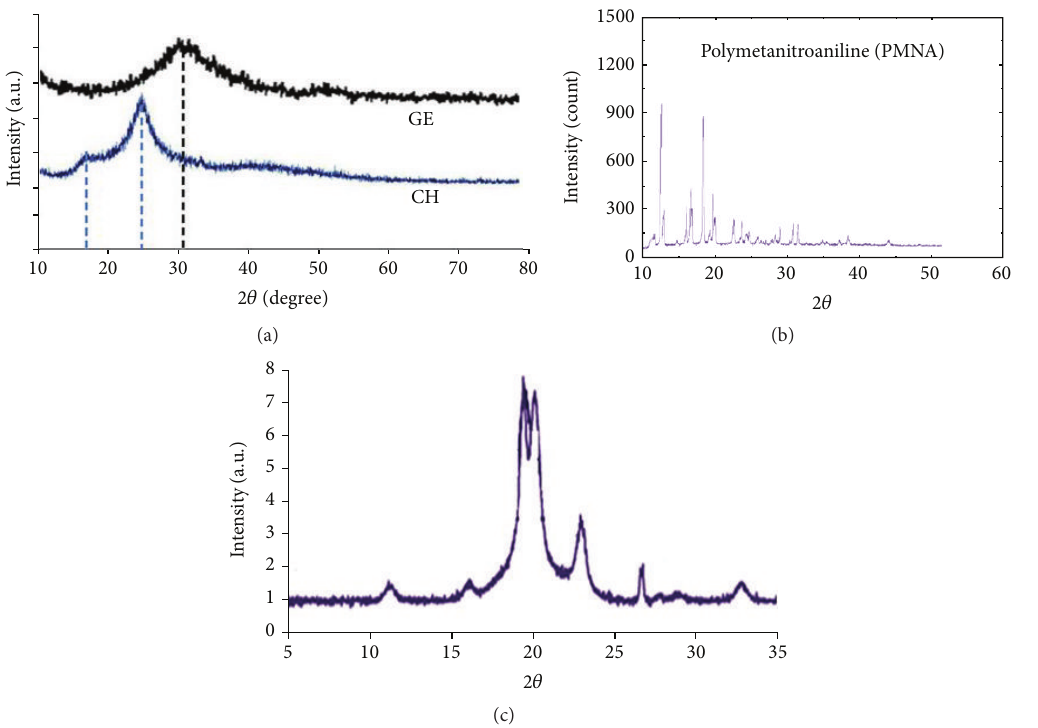
Figure 2: XRD measurements of (a) GE and CH, (b) PMNA, and (c) GE-CH-PMNA